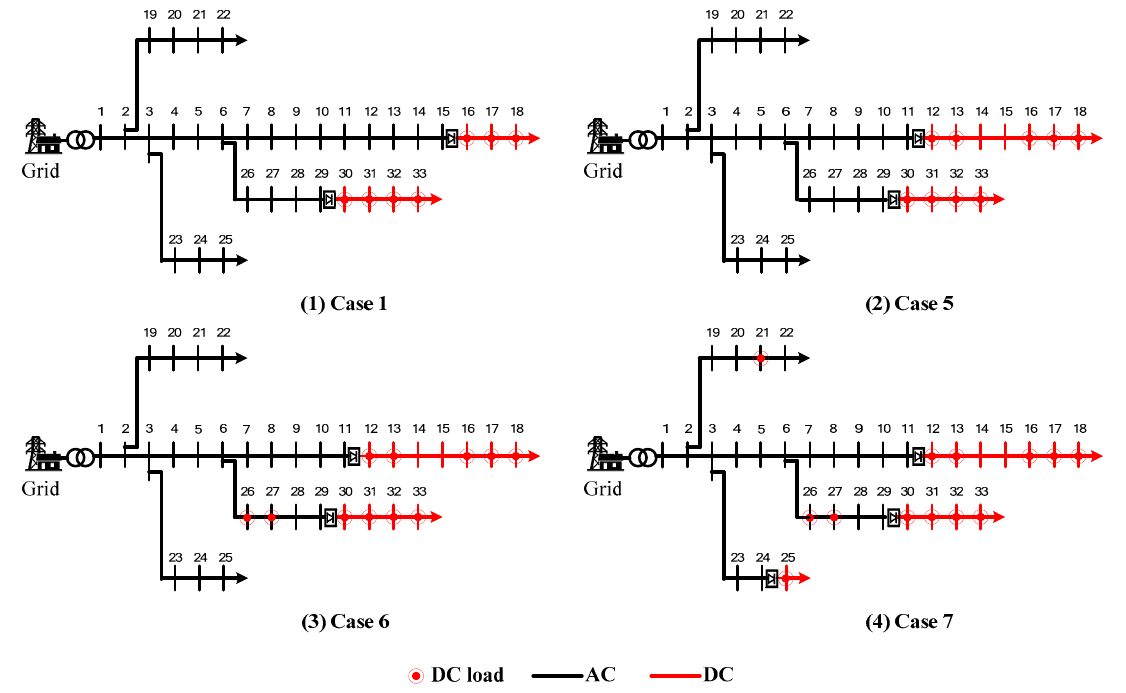
Figure 10. Influence of the distribution of DC loads on the formation of DC feeders.